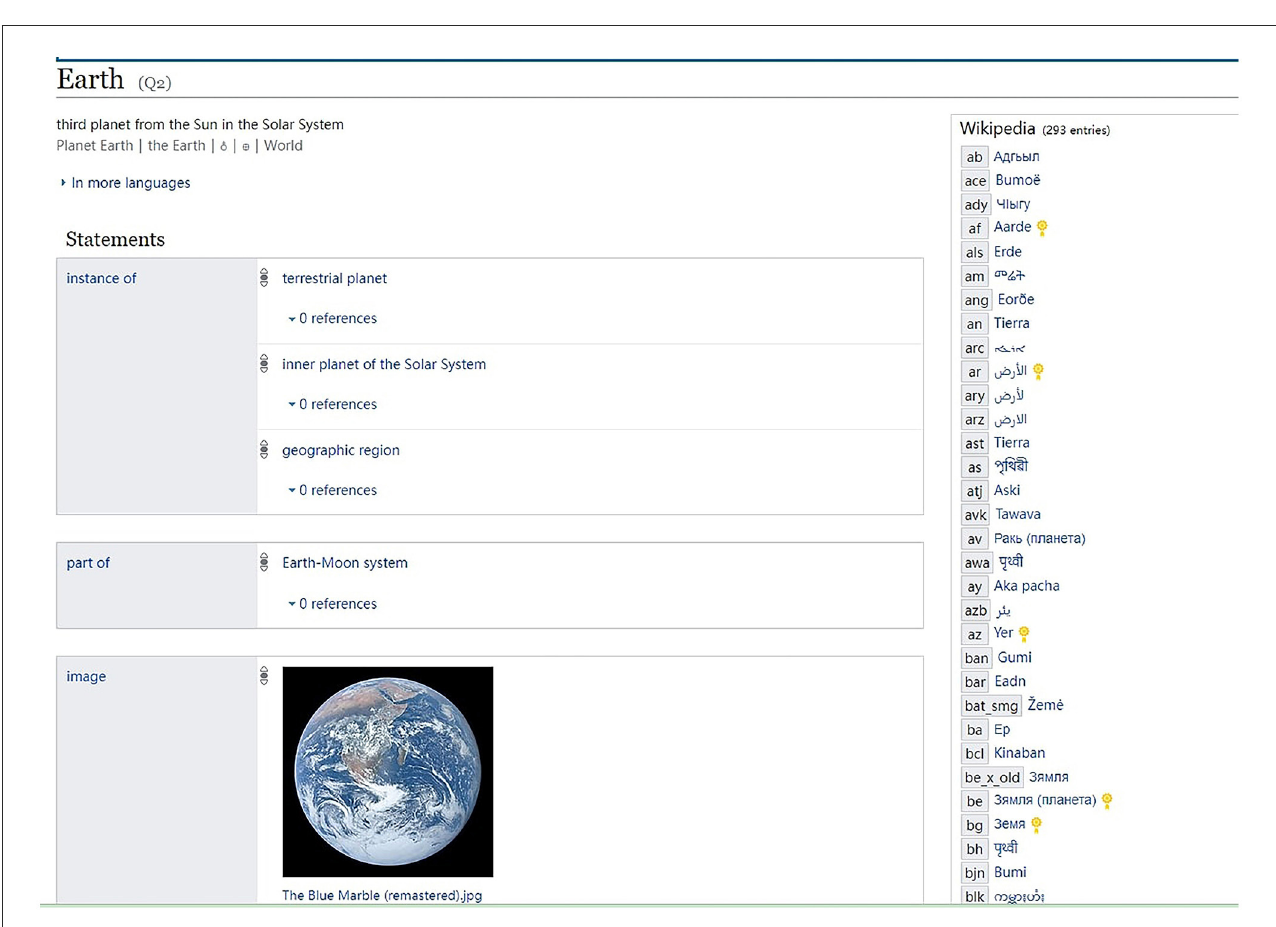
FIGURE3 Earth in Wikidata